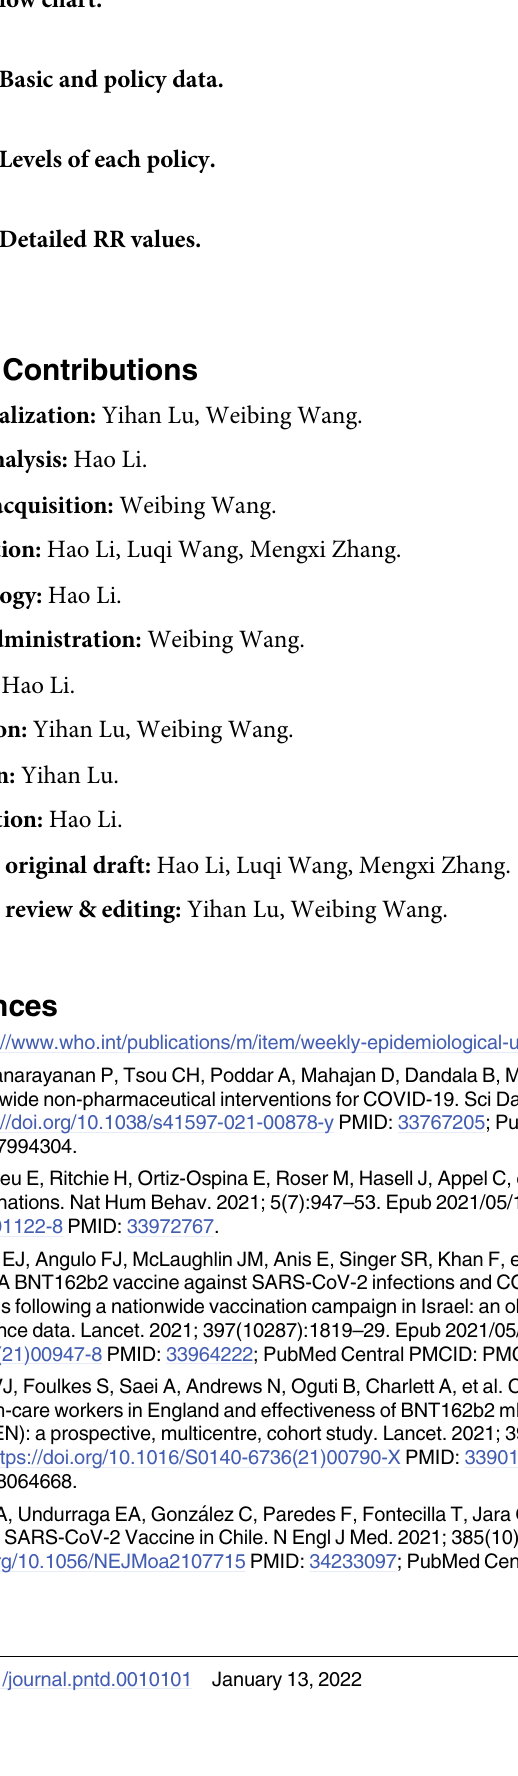
S17 Fig. Flow chart. S1 Table. Basic and policy data. S2 Table. Levels of each policy. S3 Table. Detailed RR